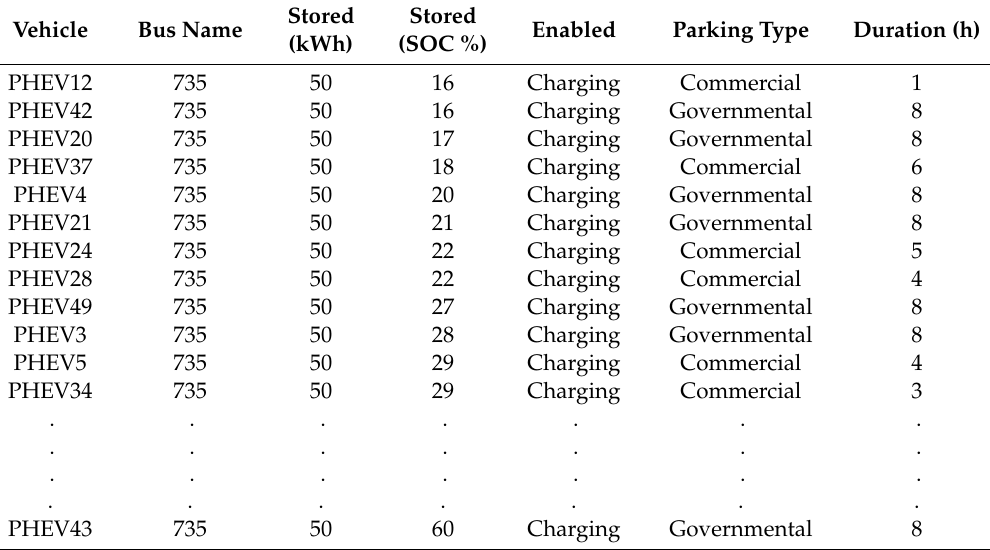
Table 3. Plug-in electric vehicle (PHEV) storage charging characteristics.